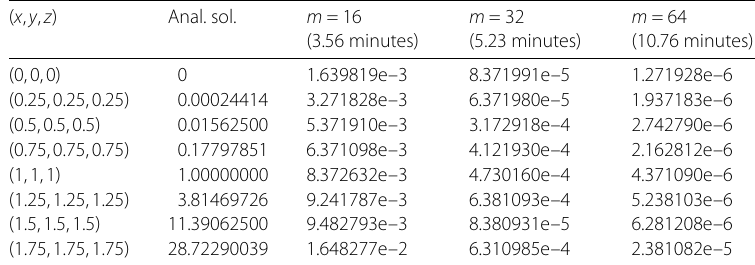
Table 1 The absolute error in some nodes of x , y and z when m = 16,32 and 64 for Example 6.1